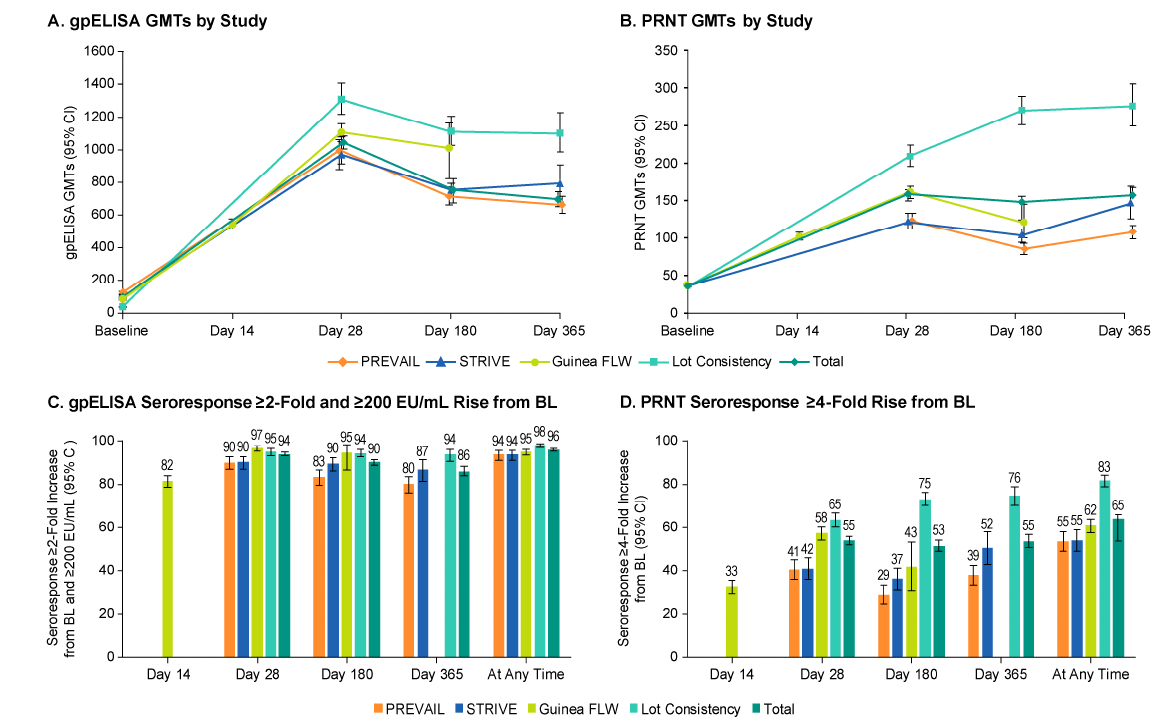
Figure 3. Glycoprotein-enzyme-linked immunosorbent assay (GP-ELISA), plaque reduction neutralization test (PRNT), and seroresponse results by study for Partnership for Research on Ebola Virus in Liberia (PREVAIL), Sierra Leone Trial to Introduce a Vaccine against Ebola (STRIVE), Guinea Front Line Worker (FLW) trial study, lot consistency study, and integrated results. ( A ): GP-ELISA GMTs ( B ): PRNT GMTs ( C ): GP-ELISA seroresponse ≥ 2-fold and ≥ 200 EU/mL rise from baseline (D): PRNT seroresponse ≥ 4-fold rise from baseline. Table 3. GP-ELISA, PRNT, and seroresponse results by study for PREVAIL, STRIVE, FLW, lot consistency study, and integrated